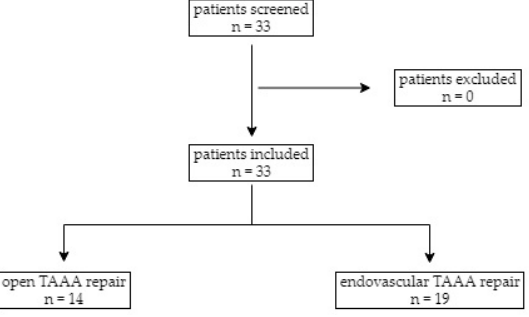
Figure 1. Screening and exclusion of patients.